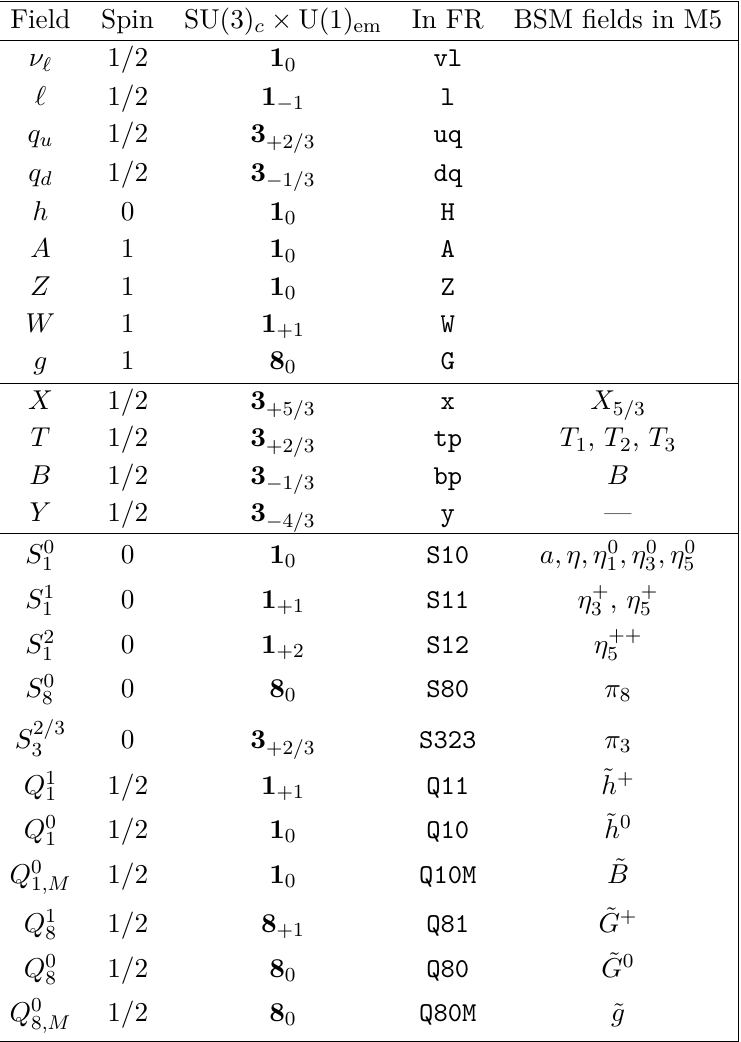
Table 3. FeynRules (FR) notation for SM and BSM fields. The upper two panels form the basis of the implementation. For the fields in the lower panel, the interactions with the upper two are implemented. The right most column shows the fields in M5 that can be described with the respective